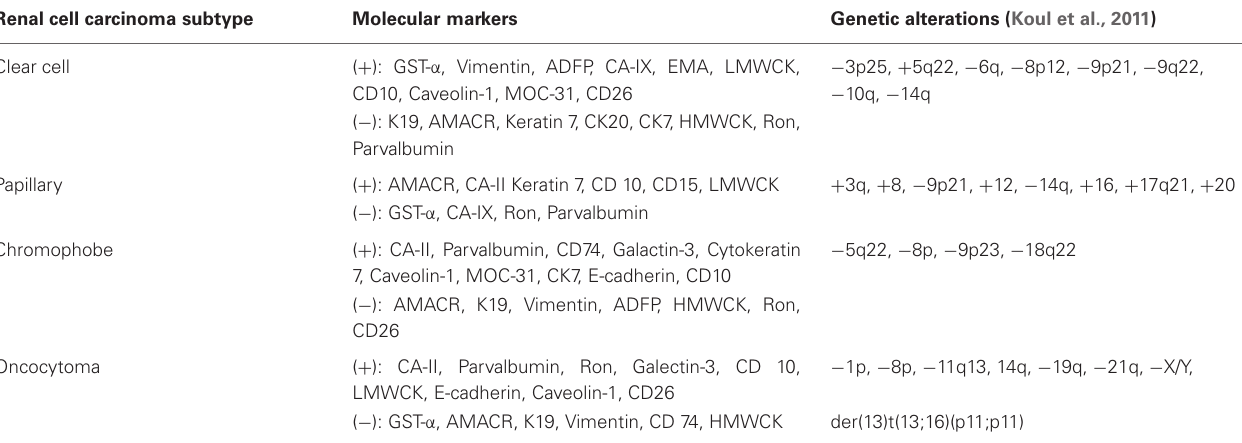
Table 1 | Molecular markers and genetic alterations of subtypes of renal cell carcinoma. Renal cell carcinoma subtype Molecular